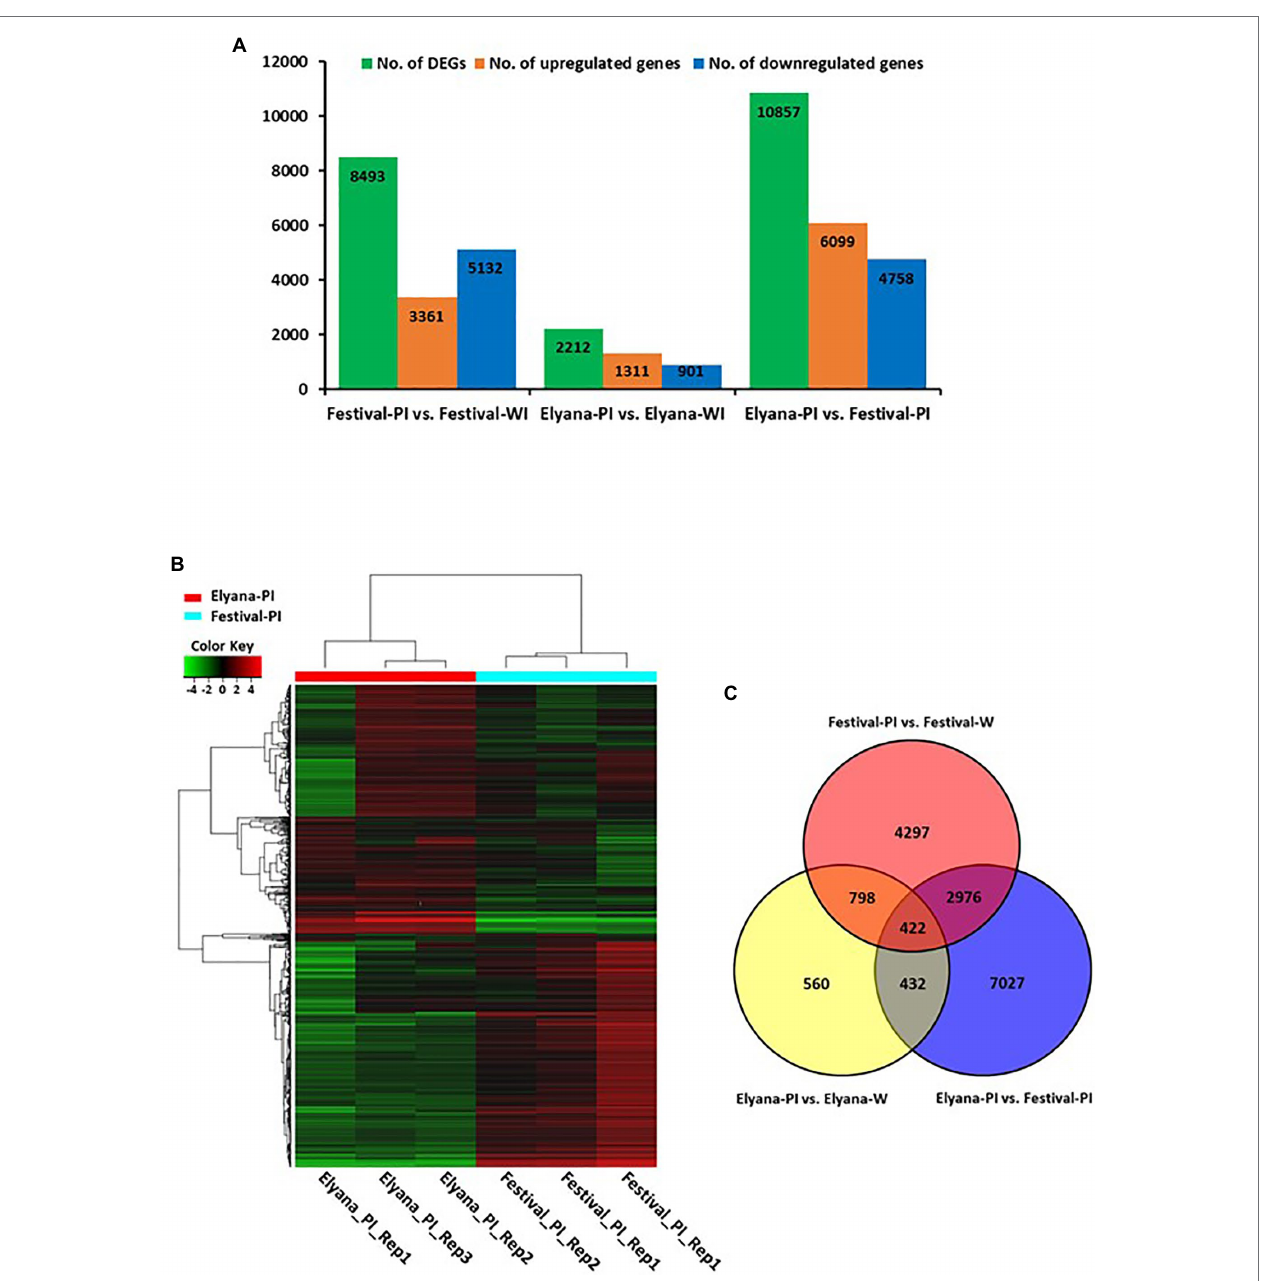
FIGURE 1 | (A) Histogram representing the number of differentially expressed genes (DEGs) detected on pairwise comparison between libraries. (B) Hierarchical clustering of genome-wide differentially expressed genes in response C. gloeosporioides . (C) Venn diagram depiction among Elyana-PI vs. Festival-PI, Elyana-Water vs. Elyana-PI and Festival-Water vs.